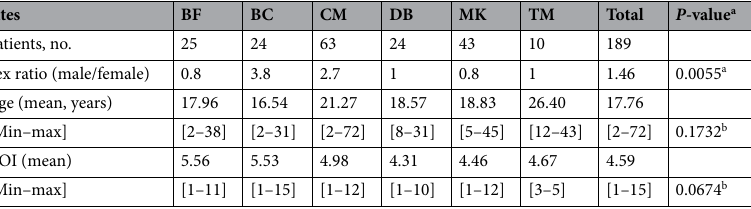
Table 1. Patient demographic data and complexity of Infection a Indicates test performed using Chi-square. b Indicates analysis performed with One-way ANOVA. BF Bandafassi, BC Bantaco, CM Camp Millitaire, DB Dalaba, MK Mako, TM Tomboronkoto, COI Complexity of